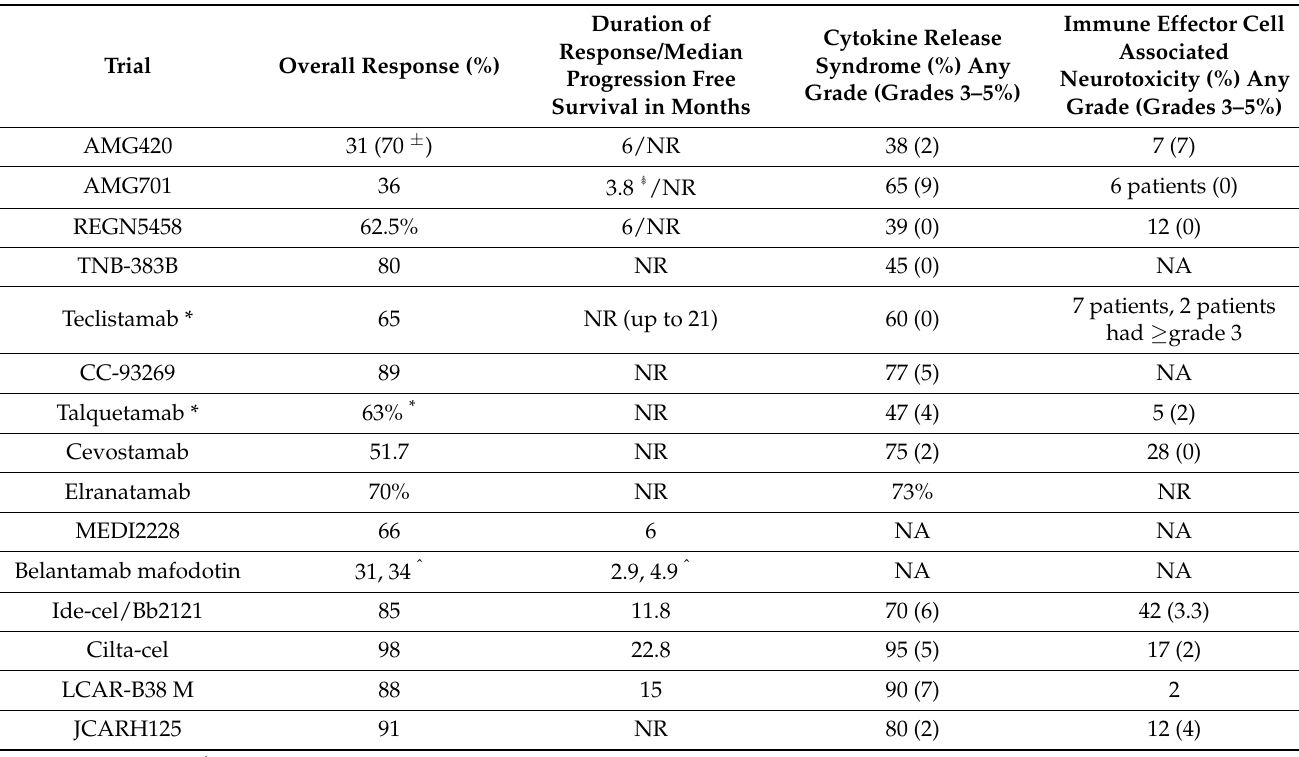
Table 2. Clinical trials of Bispecific antibodies, Antibody-drug conjugate and Chimeric antigen receptor therapy in relapsed refractory multiple myeloma. Table 1. Clinical Trials of Monoclonal Antibody in Multiple Myeloma.